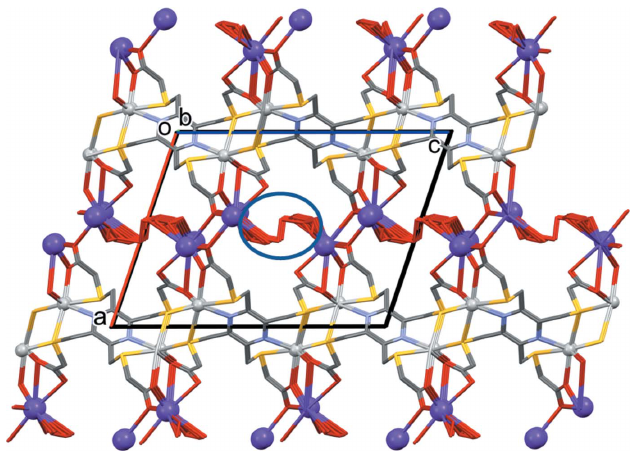
Figure 4 A view along the b -axis of the crystal packing of compound I . The silver atoms are shown as small silver balls and the potassium ions as large purple balls. The blue ellipse indicates the region occupied by the disordered water molecules. For clarity, the C-bound H atoms have been omitted.